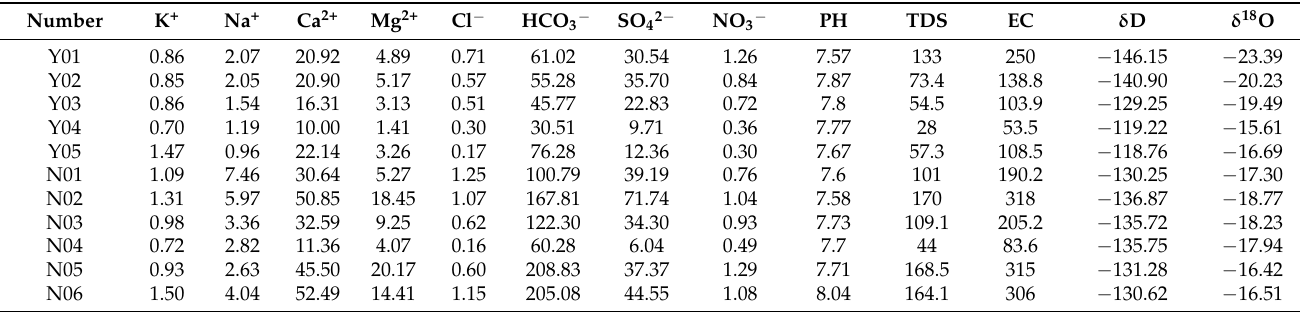
Table 1. Mass concentration statistics of main hydrochemical